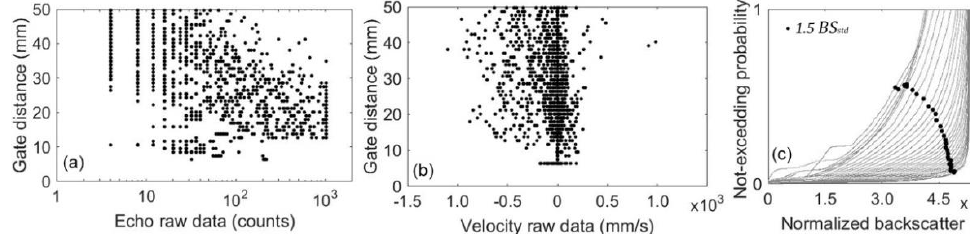
Figure 3. UVP analysis for a test with R c / H s = 0. Profiles of raw echo intensity levels ( a ) and velocities ( b ), negative values are for inshore direction; the probability distribution of normalized backscatter ( BS n ) and corresponding threshold ( BS std indicated with dot marks) at each of the validated gates ( c ).